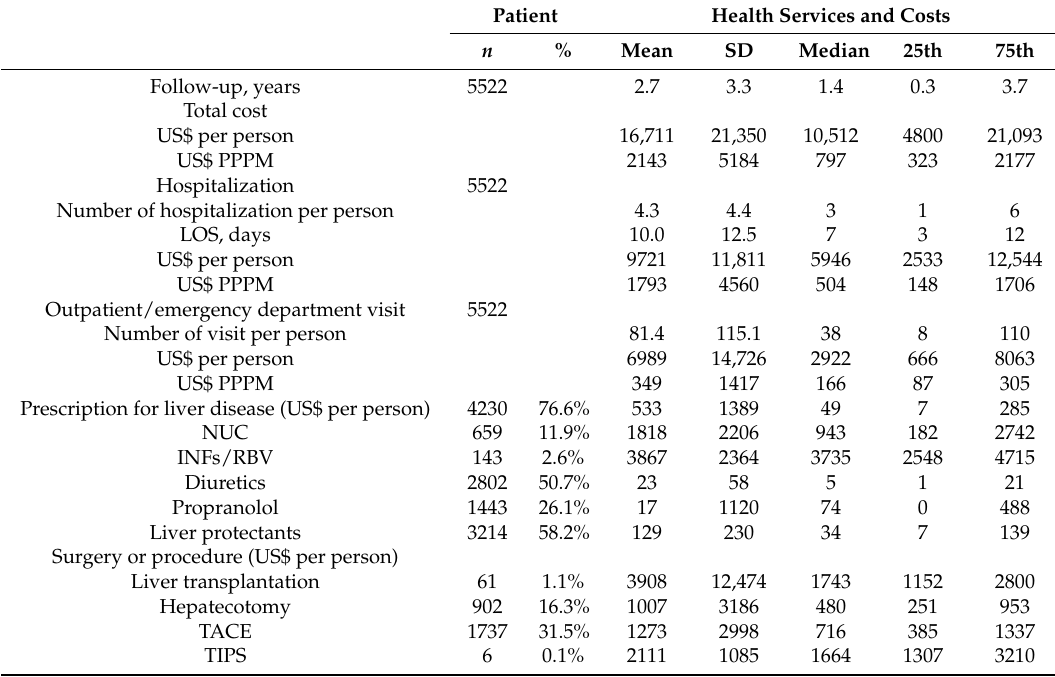
Table 3. Heath service use and costs among HCC